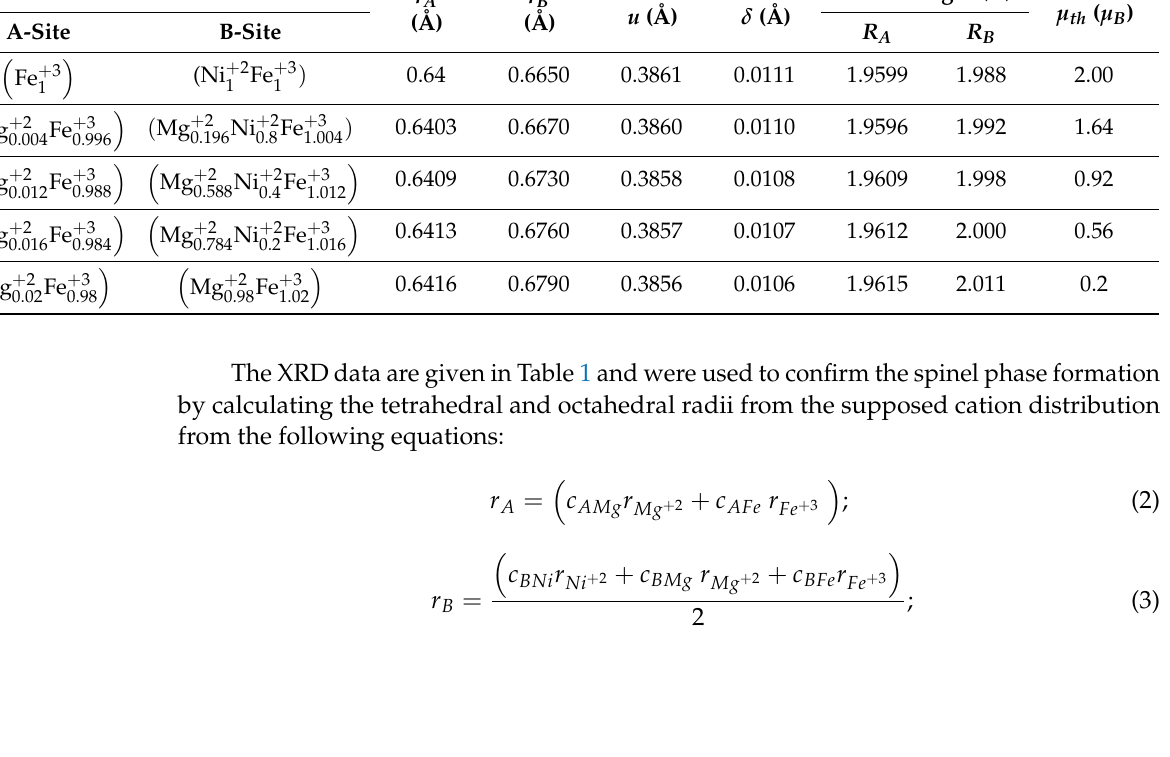
Mg + 2 Fe + 3 O 4 . x 2 1 − x